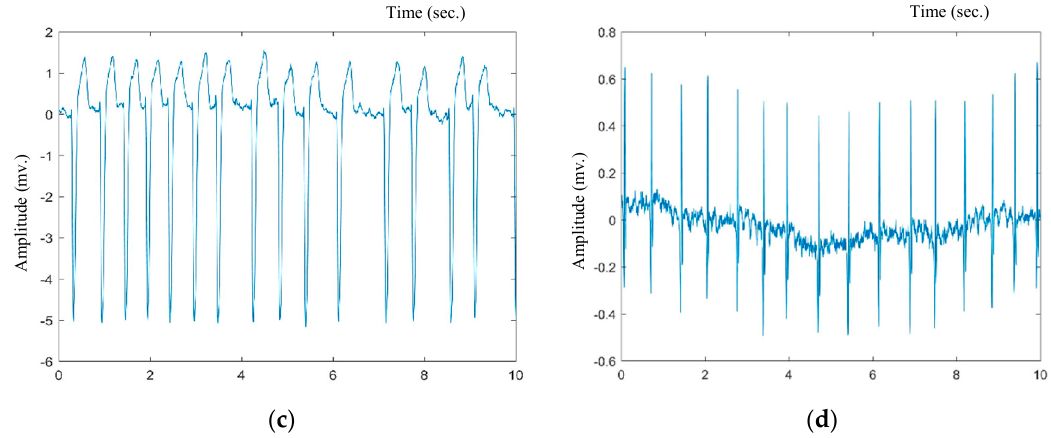
Figure 2. Samples of manually annotated P-waves in the MIT-BIH AF database, where the P-wave is absent in case of atrial fibrillation, ( a ) 07162 record; ( b ) 04126 record; ( c ) 06426 record; and ( d ) 06995 record.